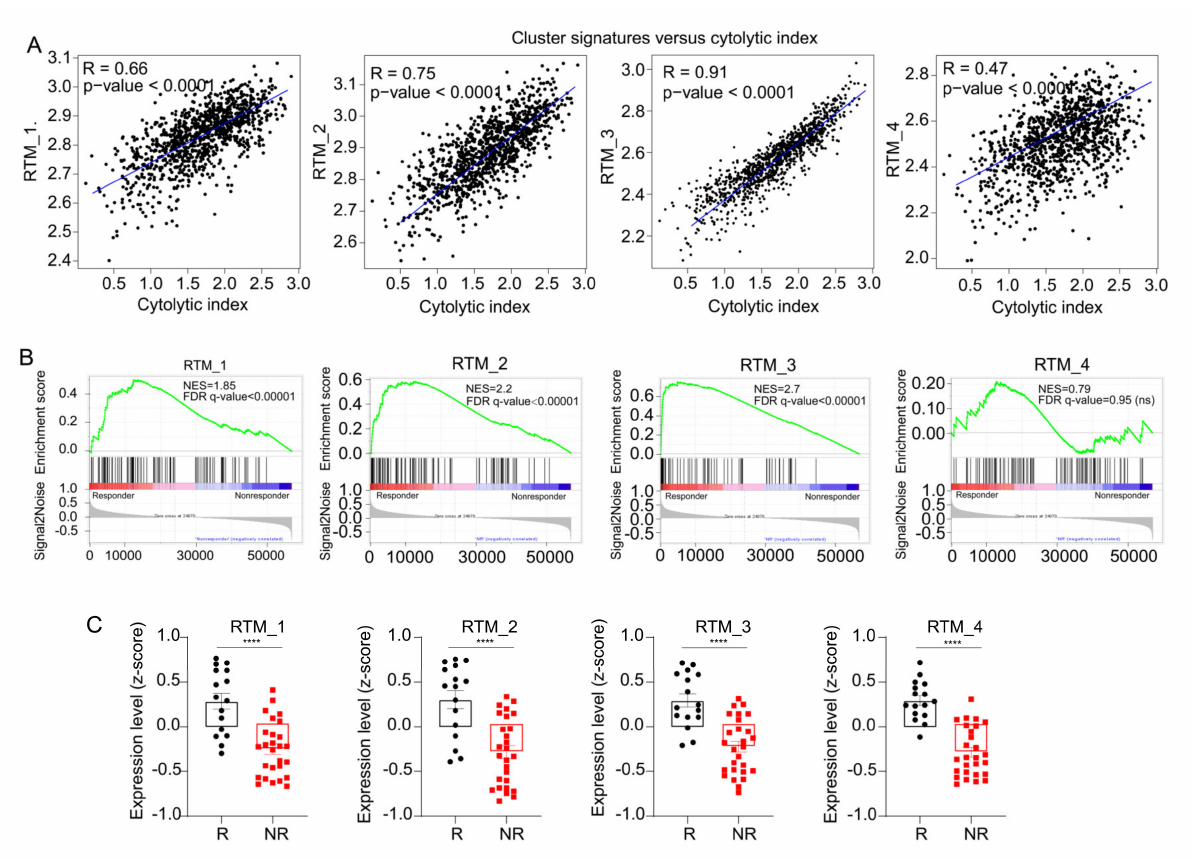
Figure 5. RTM clusters are associated with immune checkpoint therapy. ( A ) Correlation curves between RTM gene signatures and cytolytic index in TCGA cohort. ( B ) Analysis of bulk RNA-seq data of 43 breast cancer samples before ICT treatment using the GSEA. Results showed that gene signatures from each RTM cluster (see Table S4), excluding RTM_4, were significantly enriched in responders (n = 16) compared with nonresponders (n = 27). ( C ) Expression assessed by average z-score of each RTM cluster signature in responding (R) and nonresponding (NR) patients with BC. **** p < 0.0001, measured with unpaired t